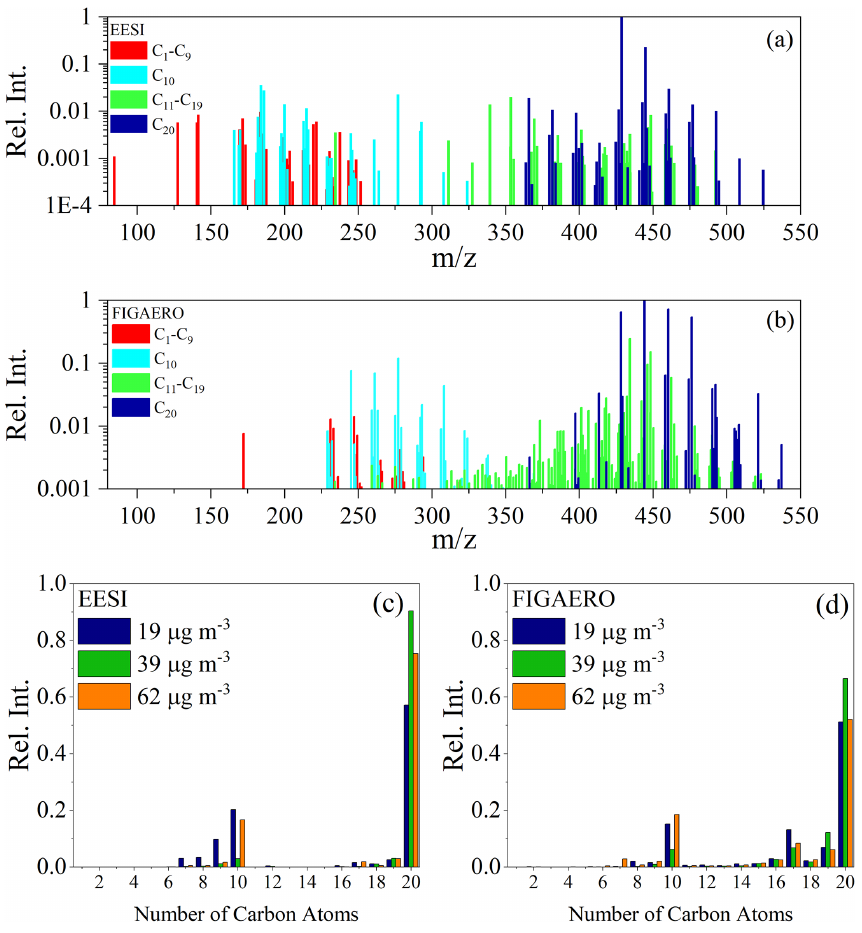
Figure 2. The average mass spectrum presented for (a) the EESI-ToF for the first 20min of the experiments and for (b) the FIGAERO- CIMS from the first desorption from experiments (the first 10–46min of the experiment) for Exp. 1. The colors denote the number of carbon present in the molecules. The main set of molecules correspond to C20H32N2Ox (x = 8–13) for both instruments. (c, d) The binned carbon distribution for experiments Exp. 1–3 for the same time period for the EESI-ToF and FIGAERO, where Exp. 1 (blue), Exp. 2 (green), and Exp. 3 (orange), respectively, take place between the first 10 and 46min of the experiment.